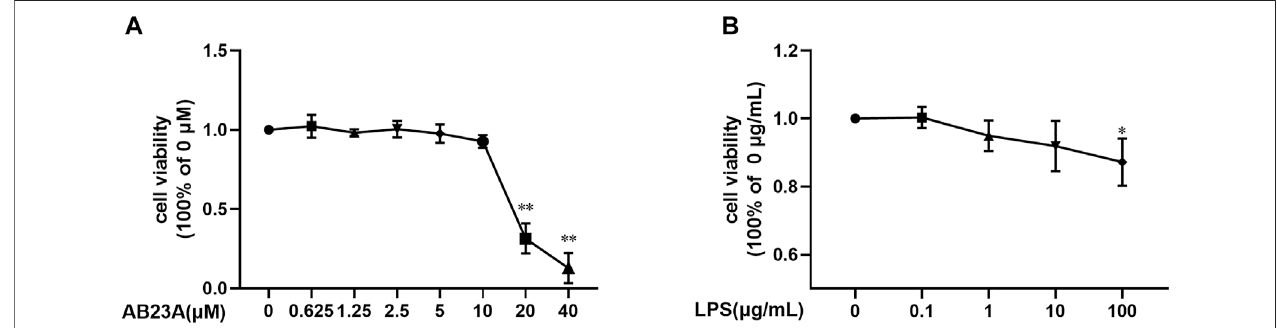
FIGURE 1 | LPS and AB23A effects on the cell viability of Caco-2 cells. Caco-2 cells underwent treatment with various AB23A or LPS concentrations for 12 h. (A) Effect of different concentrations of LPS in Caco-2 cell viability. (B) Effect of various AB23A concentrations on Caco-2 cell viability. ** p < 0.01 vs. AB23A (0 μ M) or LPS (0 μ